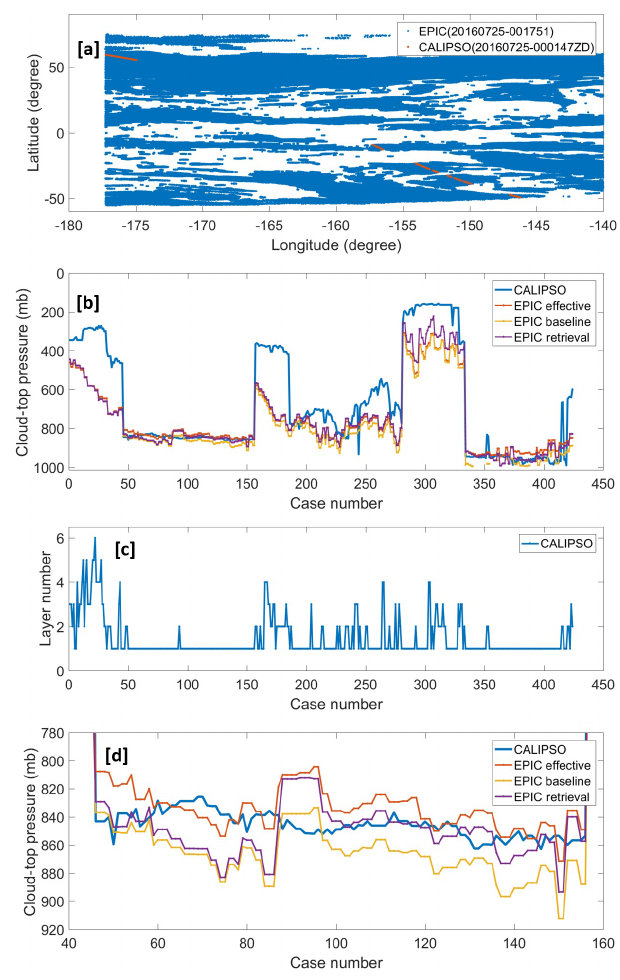
Figure 7. (a) The geolocation match of an EPIC measurement at 00:17:51GMT and CALIPSO measurement at 00:01:47GMT on 25 July 2016; (b) comparisons of cloud layer top pressure from CALIPSO measurements and the CTPs derived from EPIC mea- surements; (c) the cloud layer number from CALIPSO measure- ments; and (d) the expanded view of (b) for some cases under single-layer cloud